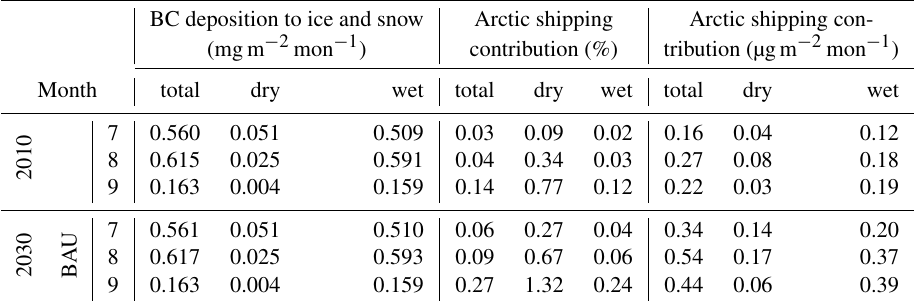
Table 10. Averaged BC deposition on ice and snow over the Canadian Arctic (60–90 ◦ N, 50–140 ◦ W), and contributions from shipping over the Canadian Arctic